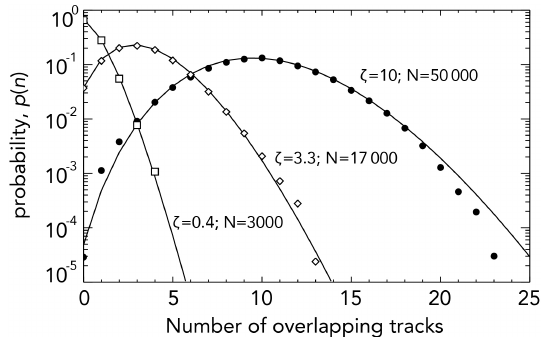
Figure 3. Probability density functions p(n) derived from the Monte Carlo simulations of overlapping rectangular tracks for three values of the mean track density ζ (0.4, 3.3, and 10). For the sim- ulations, a domain of size 4000 × 4000km is modeled, using a 4000 × 4000 array, and tracks of length 1200km and width 44km (see Sect. 2.5) are placed randomly in relation to the array, assuming periodic boundary conditions. The long dimension of each track is randomly set to be parallel to the i or j direction of the box. Poisson distributions (Eq. 8) are shown correspondingly, based on the mean track densities, and represent an excellent fit to the data. The track densities ζ = 0 . 4, 3.3, and 10 correspond to a total number of ships, if spraying were to take place over the entire eligible ocean region of ∼ 3000, ∼ 17000, and ∼ 50000,